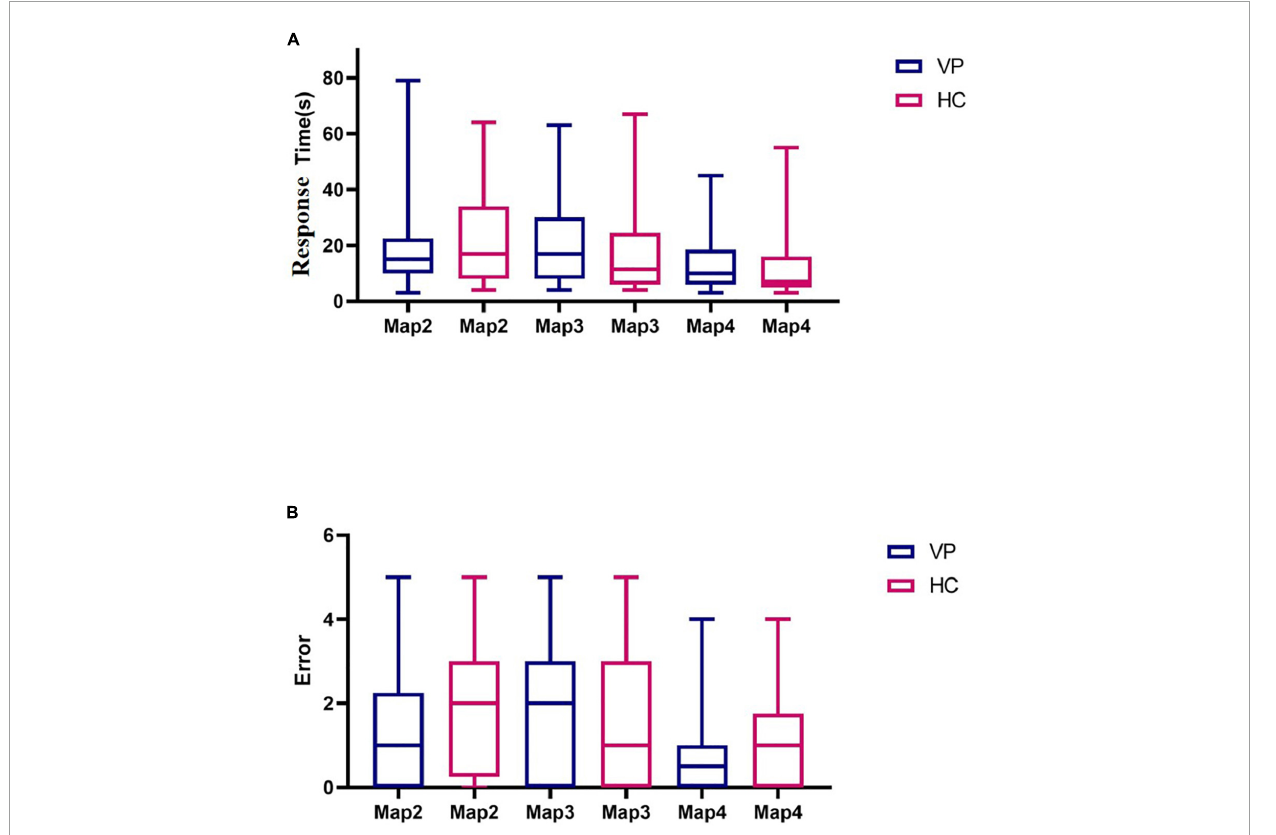
FIGURE13 Comparison of three dimensional (3D) driving test indexes between VP and HC. (A) Response time spent in Maps 2, 3, and 4 for VP and HC, respectively. (B) The number of errors in Maps 2, 3, and 4 of VP and HC, respectively. The upper and lower lines represent the 95th and 5th percentiles, respectively, and the horizontal line within the box is the median. VP, patients with vertigo; HC, healthy